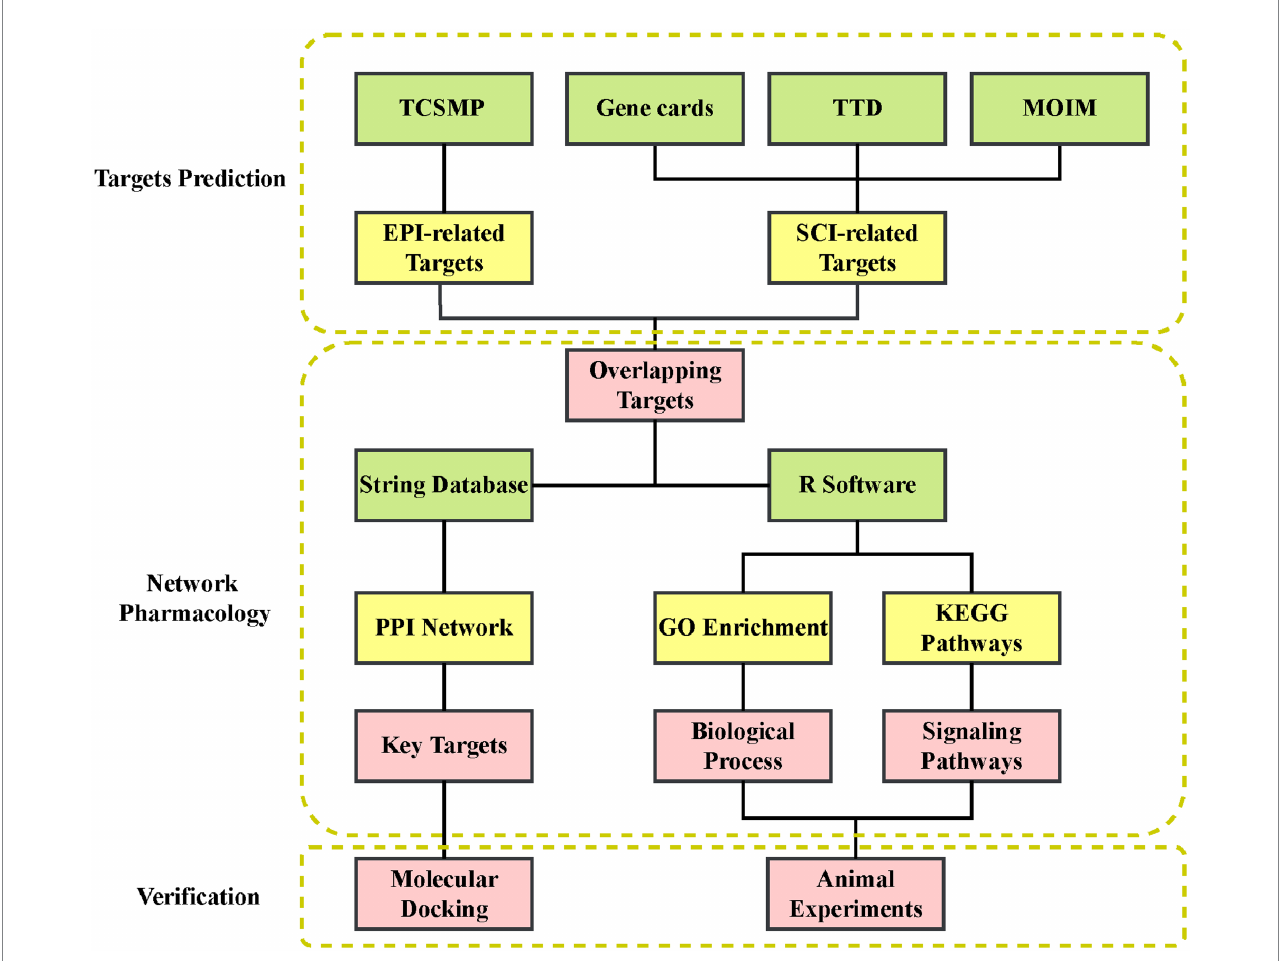
FIGURE 1 The analysis program flowchart of the